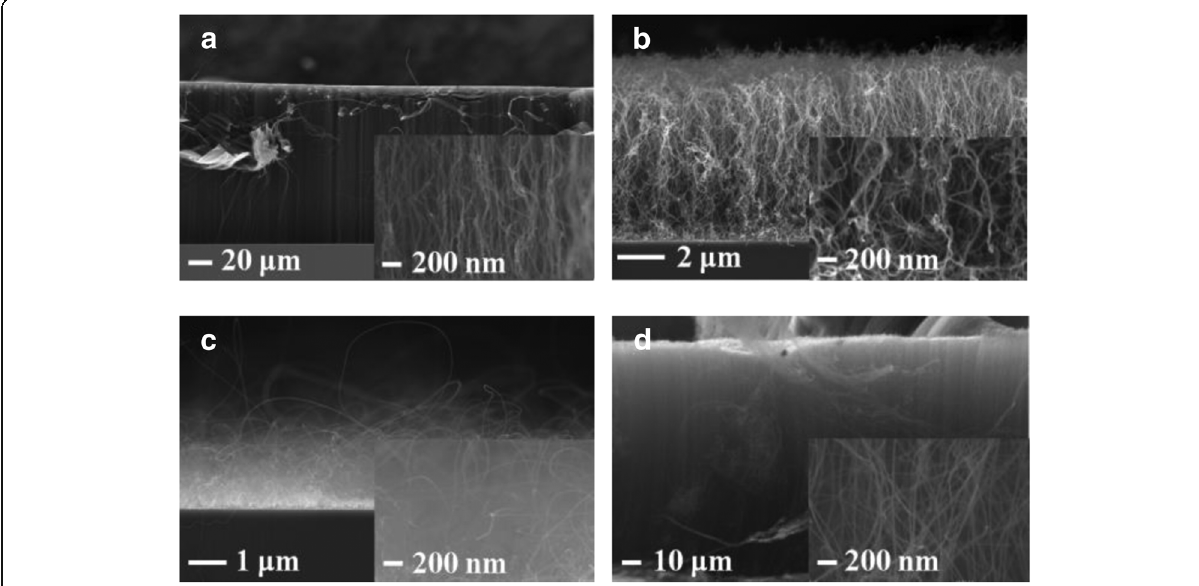
Fig. 2 Cross-sectional SEM images of VACNTs grown on different oxide buffer layers at 650 °C: a Al 2 O 3 , b TiO 2 , c ZnO, and d SiO